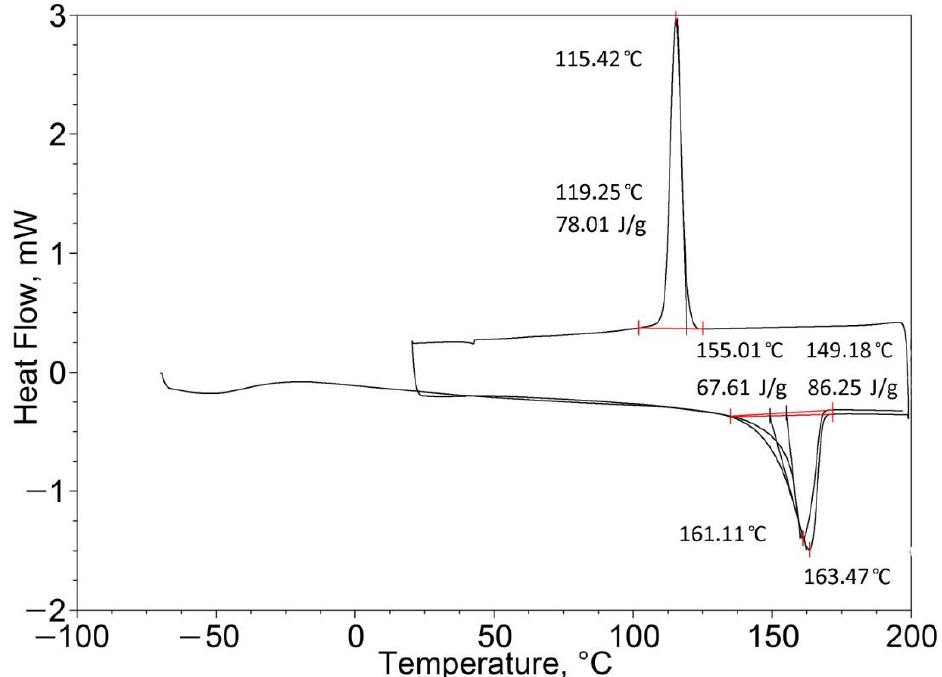
Figure 15. Melting-crystallization-melting diagram (DSC thermograms) of the 75% PP – 25% EPTSR polymer blend produced by melt blending method.